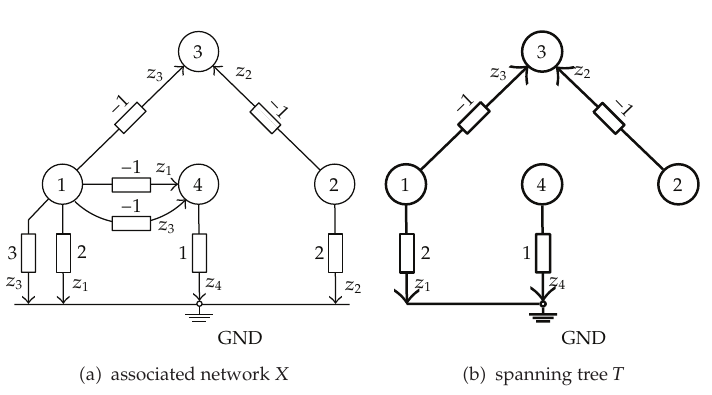
Figure 3: Four-node network